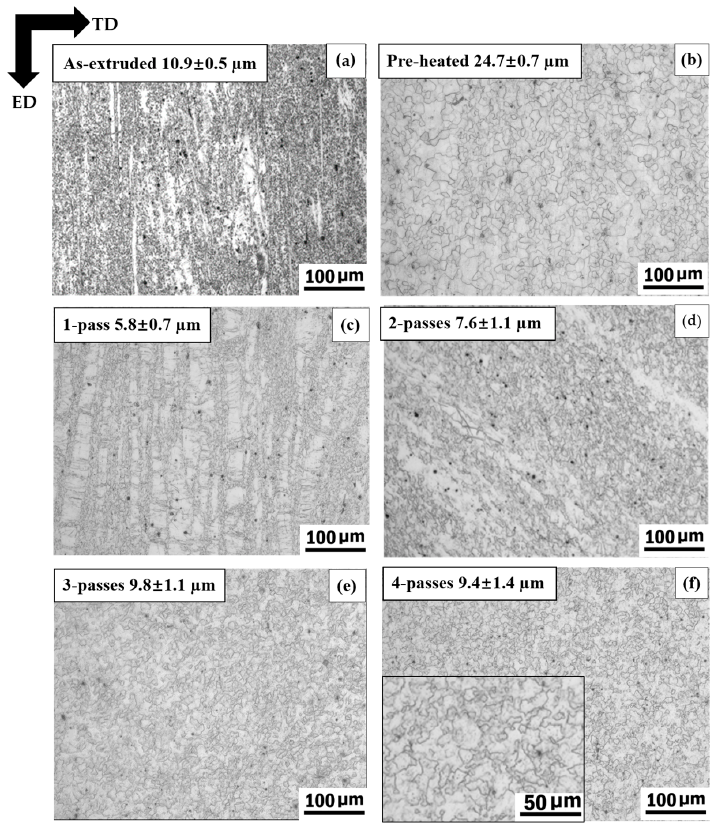
Figure 3. Optical microscope images of ( a ) as-extruded Mg-1Y alloy; ( b ) as-extruded Mg-1Y alloy treated at 400 °C for 10 min before 1-pass ECAP process; ( c ) 1-pass; ( d ) 2-pass; ( e ) 3-pass; and ( f ) 4-pass ECAPed alloys.